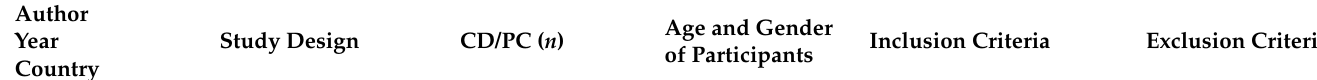
Table 2. Characteristics of the studies included in the systematic review and/or